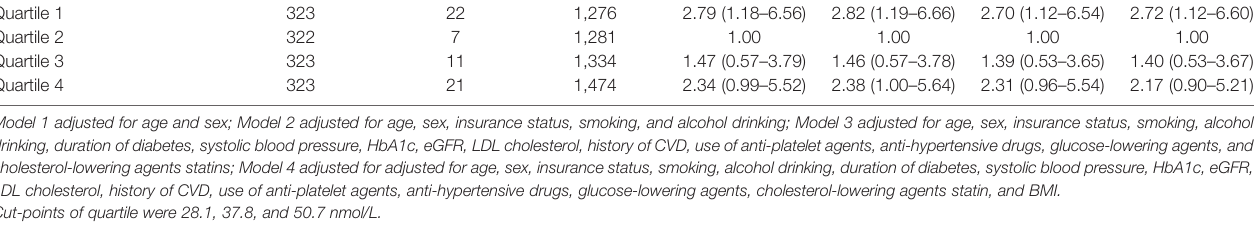
TABLE 3 | Hazard ratios of all-cause mortality by quartiles of 25-OH vitamin D levels among patients with type 2 diabetes. 25-OH Vitamin D(nmol/L) No. of Participants